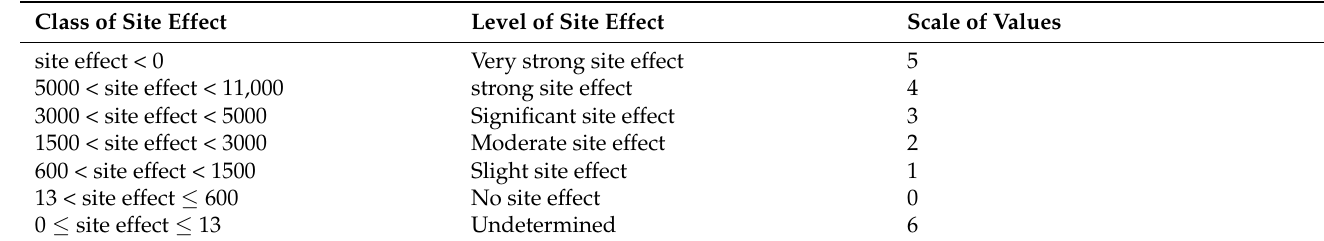
Table 4. Levels of site